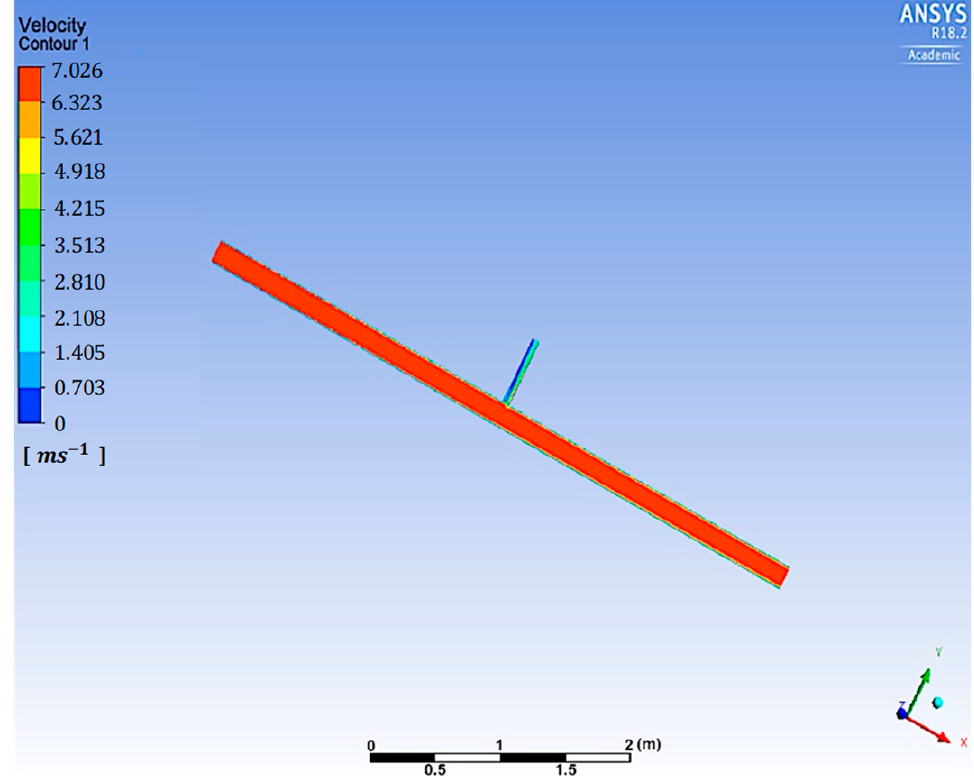
Figure 6. Result of pipe modeling analysis.